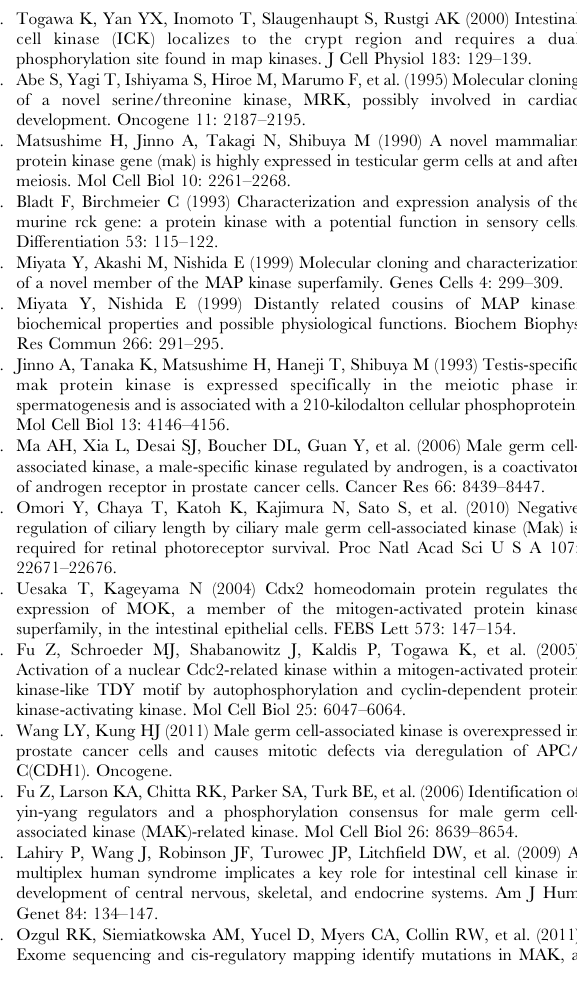
expression of MAK-1 in testis and MAK-2 in retina as well. MAK- 1 and MAK-2, but not MAK-3, were detected in mouse colon. (TIF) Figure S3 Relative abundance of ICK, MAK, and MOK proteins in young adult mouse tissues. The Western blot signals of ICK/MAK/MOK shown in Figure 2A were quantified by densitometry and normalized against the ERK2 signal. Shown here are the quantitative data indicating relative abundance of ICK, MAK, and MOK proteins in various mouse tissues.